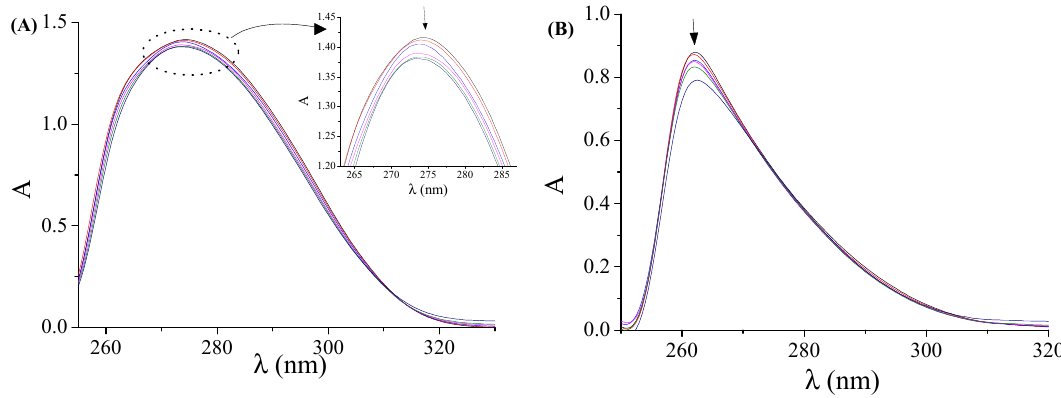
Figure 7. UV spectra of DMSO solution of compound ( A ) 9 (2 × 10 − 5 M) and ( B ) 19 (1 × 10 − 4 M) in the presence of increasing amounts of CT DNA (r’ = [DNA]/[compound] = 0–0.8). The arrows show the changes upon increasing amounts of CT DNA.